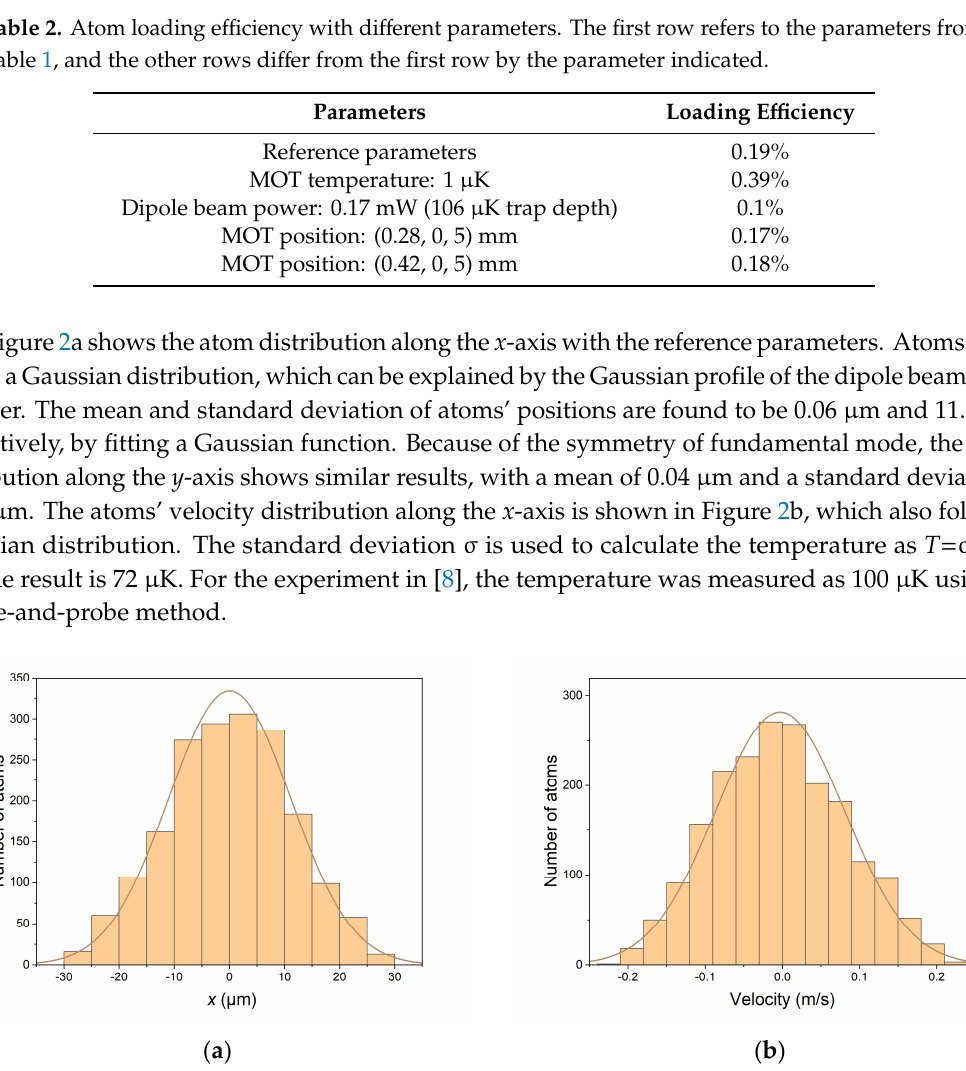
Figure 2. ( a ) Histogram of atom distribution in the x -axis. The curve is a Gaussian fit to the histogram. The mean and standard deviation of atom position are found to be 0.06 μm and 11.14 μm, respectively. ( b ) Histogram of velocity distribution along the x -axis. The curve is a Gaussian fit to the histogram. The mean and standard deviation of atom velocities are found to be −0.0029 m/s and 0.0840 m/s, respectively. The standard temperature is calculated to be 72 μK.